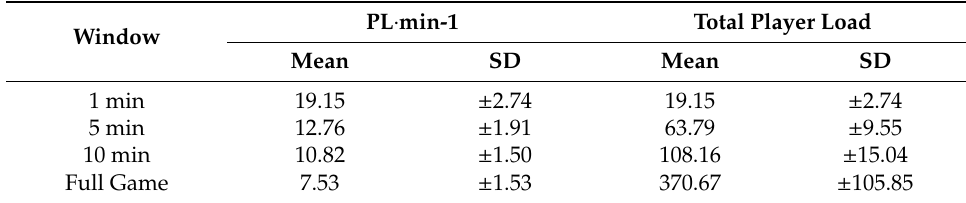
Table 1. The descriptive analysis of volume (Player Load) and intensity (PL·min-1) among different time windows.